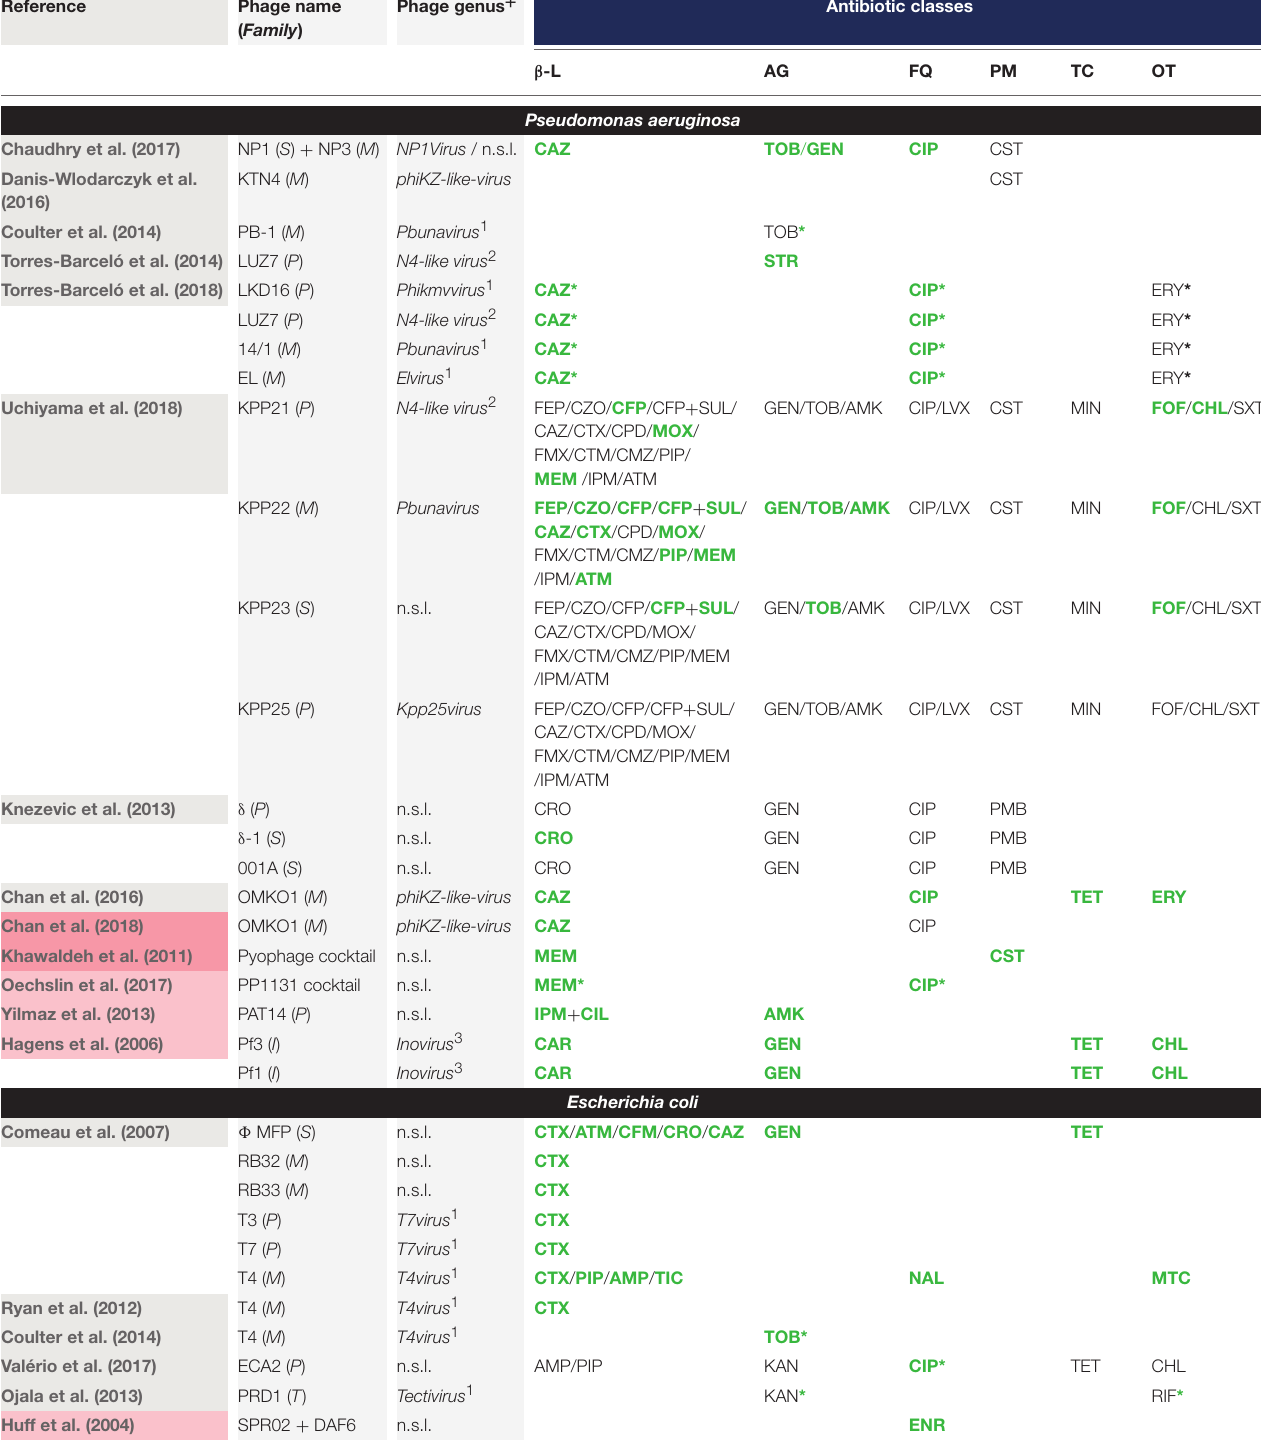
TABLE 1 | Overview of phage-antibiotic combinations tested against human pathogenic bacteria 1